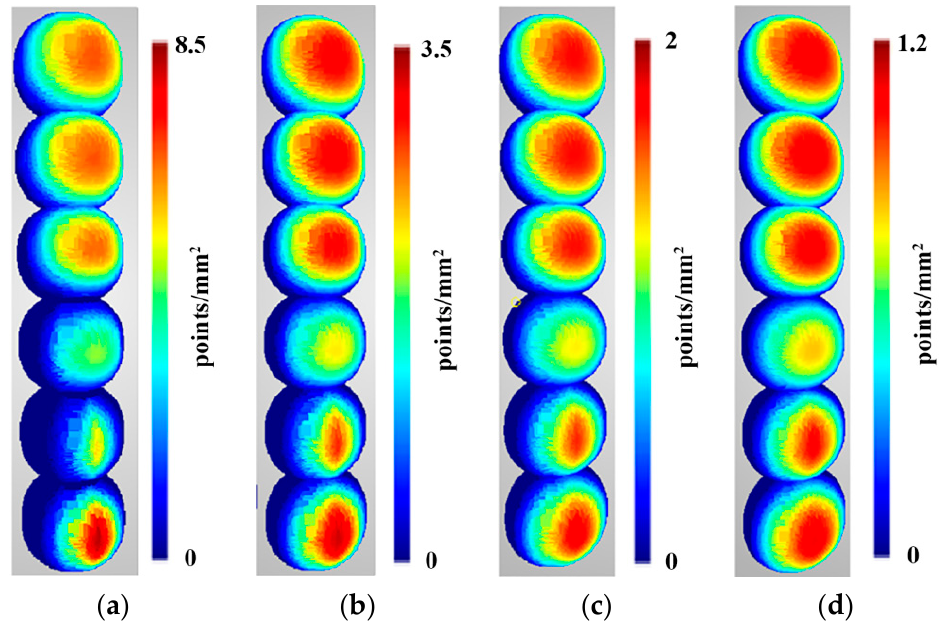
Figure 11. Density predictions of the reconstructed sphere at the following distances: ( a ) 2 m, ( b ) 3 m, ( c ) 4 m, and ( d ) 5 m. Spheres in different rows were reconstructed from scenarios with different numbers of cameras. In order from bottom to top, these were as follows: two-, three-, four-, six-, nine-, and twelve-camera scenarios.